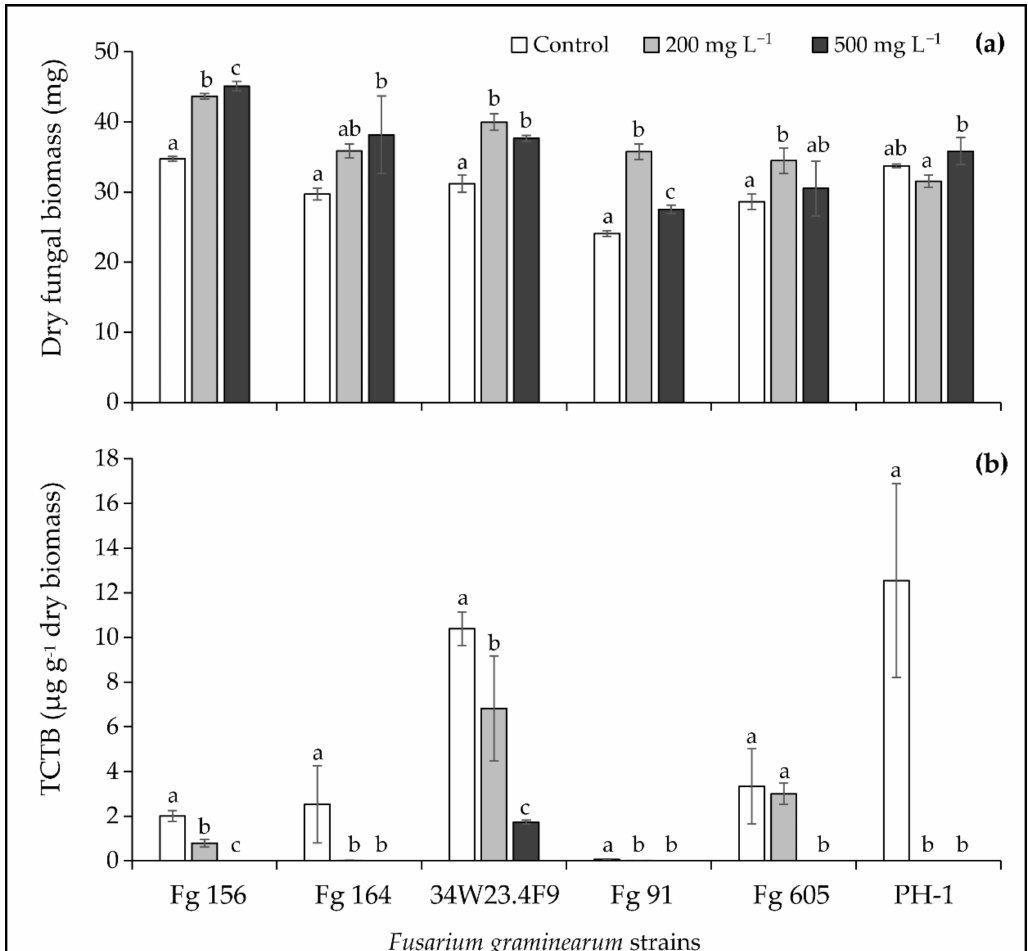
Figure 4. Effect of the maritime pine sawdust extract obtained at 175 ◦ C at 200 and 500 mg L − 1 on ( a ) fungal biomass and ( b ) type B trichothecenes (TCTB) production by six Fusarium graminearum (Fg) strains. Values are expressed as means ± standard deviation using four biological replicates. Differences between control and treated conditions in terms of fungal biomass and TCTB were determined separately for each fungal strain with multiple comparisons and the Dunn–Sidak method. For each fungal strain, different letters indicate significant differences between tested conditions ( p <